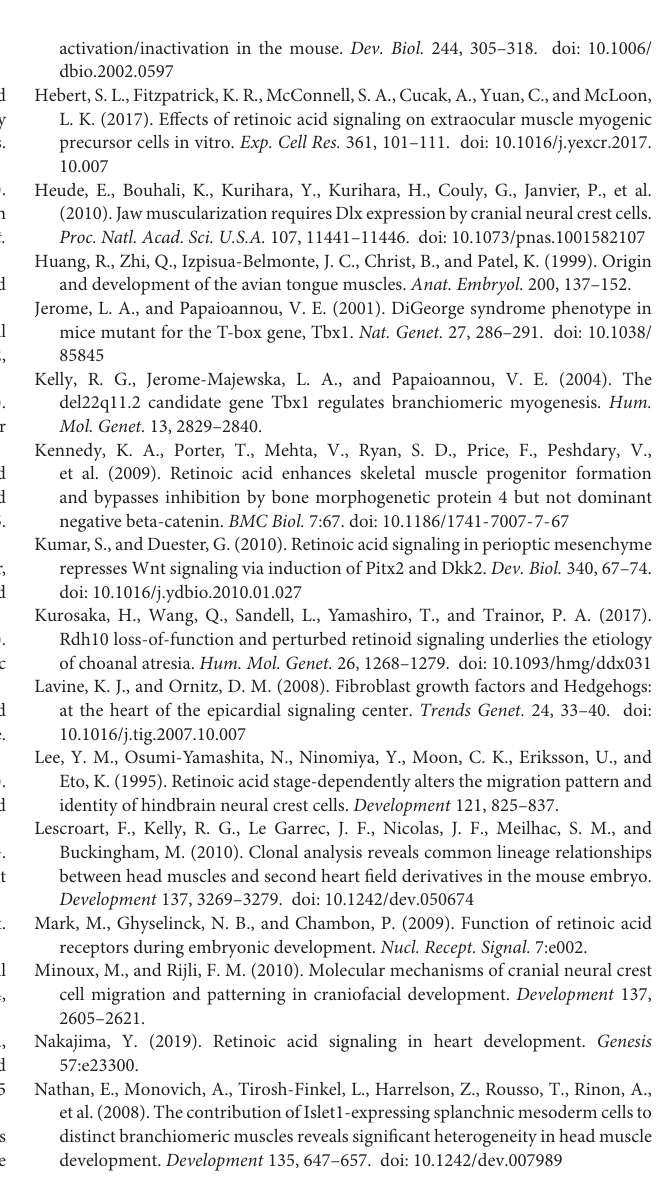
Supplementary Figure 1 | Transmission electron microscope (TEM) image of intrinsic tongue muscles. TEM images of control (A) and RA treated (B) intrinsic tongue muscle at E13.5. Scale bars; 500 nm. MF, muscle fiber.